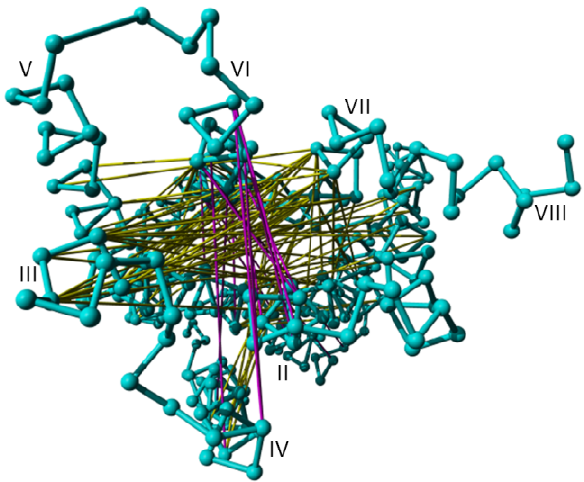
Figure 6. Distances found to be important by the random forest method to separate active from inactive structures mapped on rhodopsin (PDBid = 1f88 [2]) looked at from the intracellular side. The distances indicated in magenta increase upon activation; distances indicated in yellow decrease upon